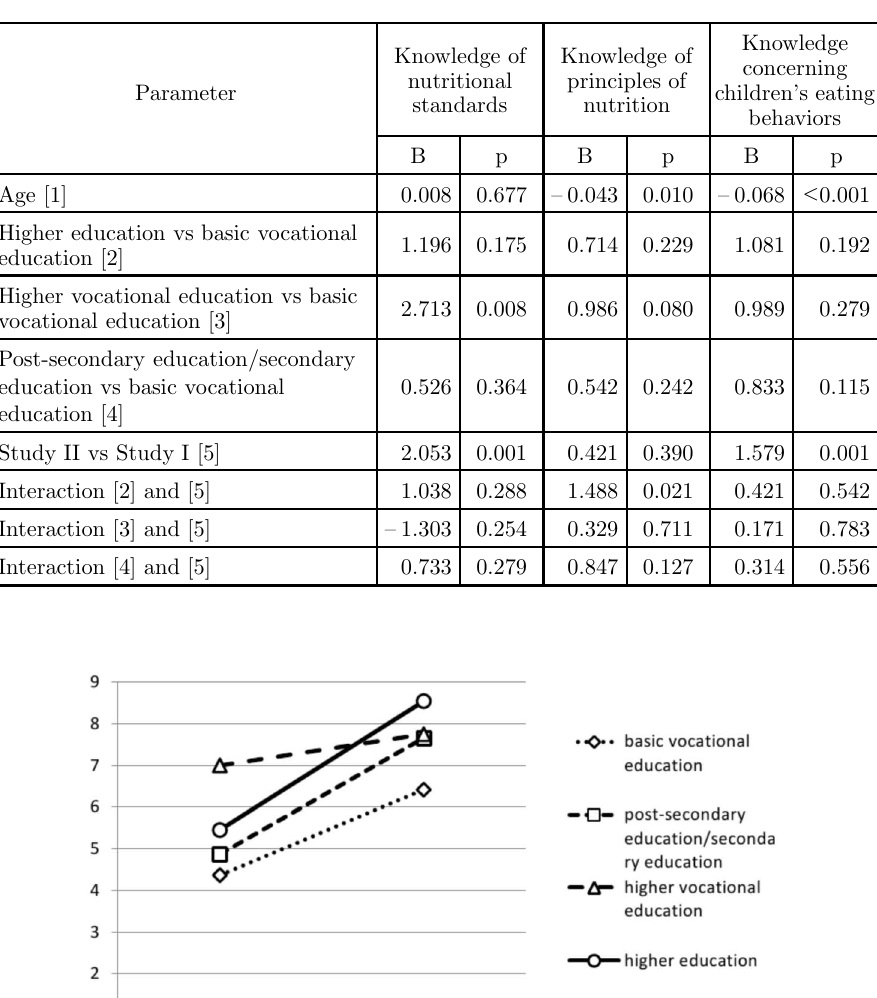
Table 1. Generalized Linear Models explaining knowledge in 3 studied areas including level of education as a covariate